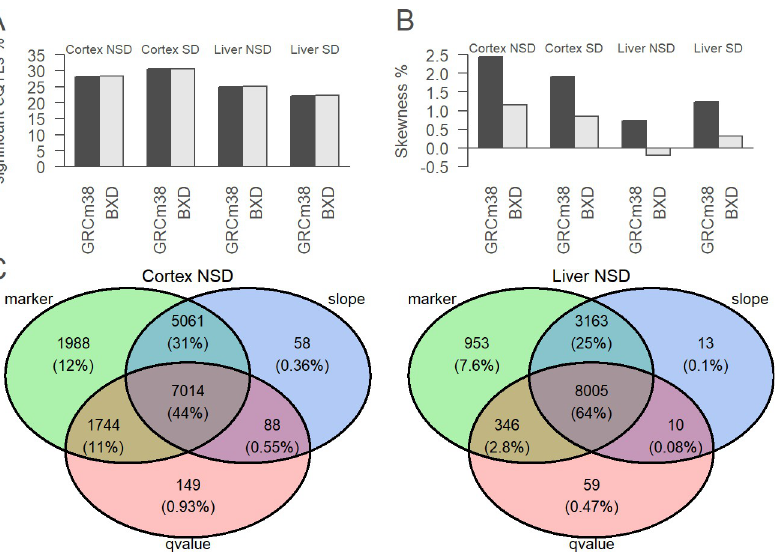
Fig 4. Consequences of mapping reference at local eQTL level. A. Percentage of significant (FDR 5%) local eQTLs over all expressed genes with GRCm38 or BXD-specific references. B. Percentage of skewness of significant (FDR 5%) local eQTLs slope over all expressed genes with GRCm38 or BXD-specific references. C. For all expressed genes, the best local genetic marker to explain gene expression was selected. The Venn diagrams represent the overlap of this analysis between GRCm38 and BXD-specific references for the three criteria in cortex NSD (left) or in the liver NSD (right). The marker (in green) indicates changing the reference result in the same genetic marker associated with gene expression. The slope (in blue) is the direction and strength of allele-specific gene expression, it is considered to be overlapping between the references if it varies less than 5%. The qvalue (in pink) is the statistical significance of the marker to gene expression association, it is considered to be overlapping between the references if it varies less than